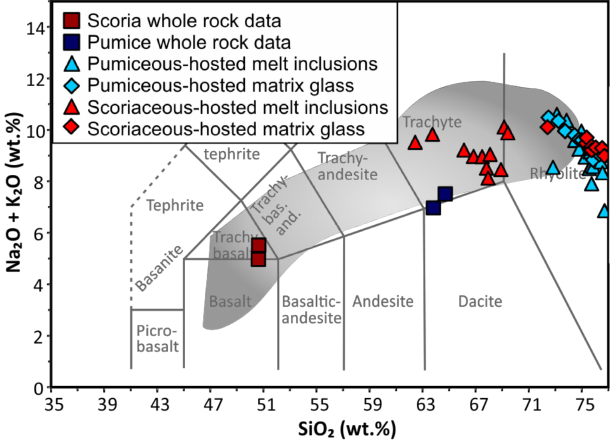
Figure 4: Total alkalis-silica plot [after Le Bas et al. 1992]. Grey field represents previously collected As- cension Island whole rock compositions from Weaver et al. [1996], Jicha et al. [2013] and Chamberlain et al.